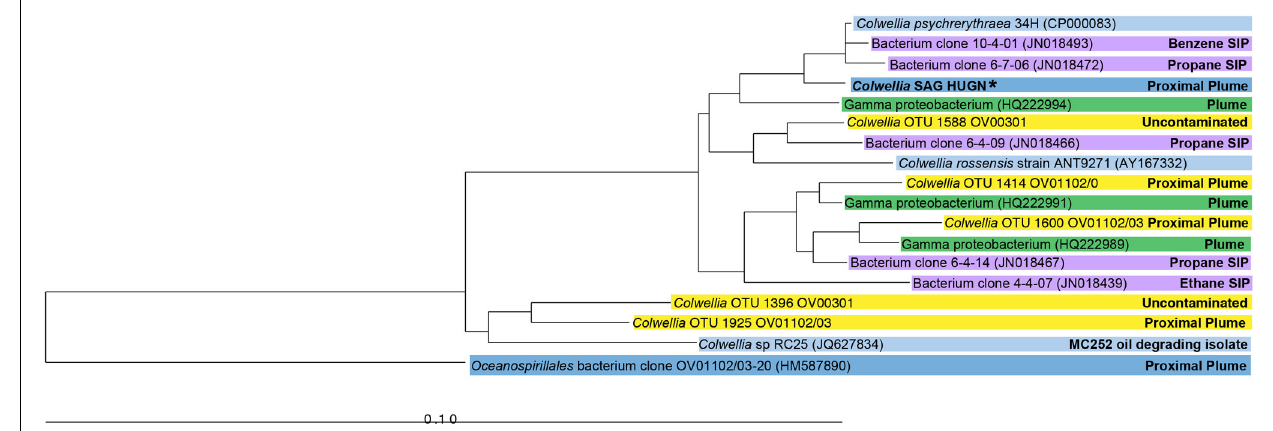
FIGURE 1 | Neighbor-joining phylogenetic tree of 16S rRNA genes of the Colwellia SAG and close relatives. Sequences from a particular study are highlighted with the same color. Information about the